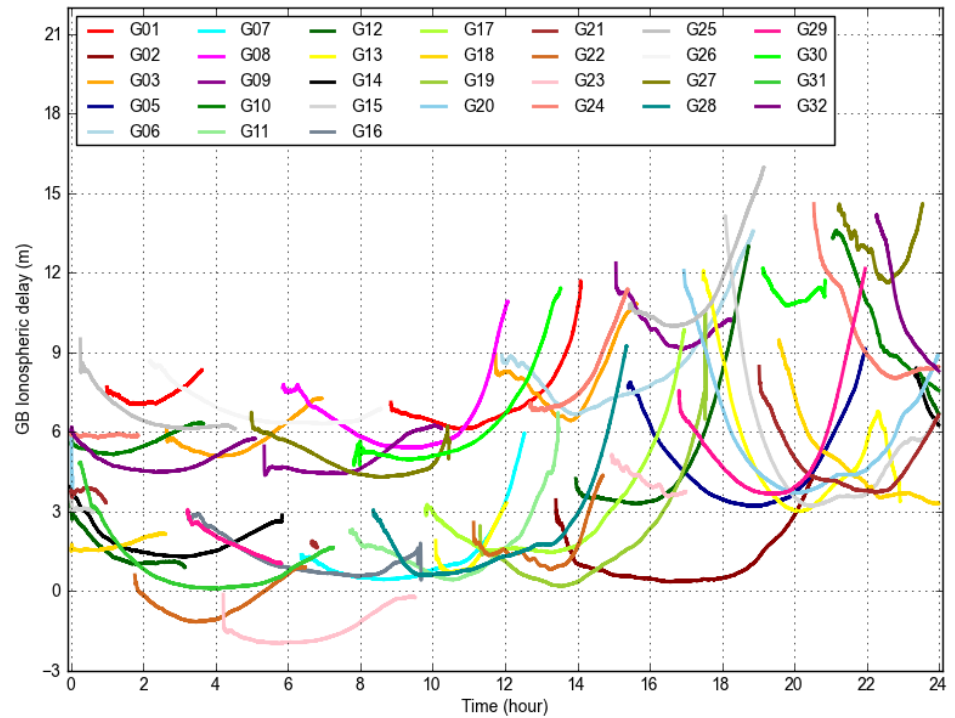
Figure 3. GB ionospheric delay estimates for all of the observed satellites computed for the single receiver (GODZ) observations and the ESA final OC products.